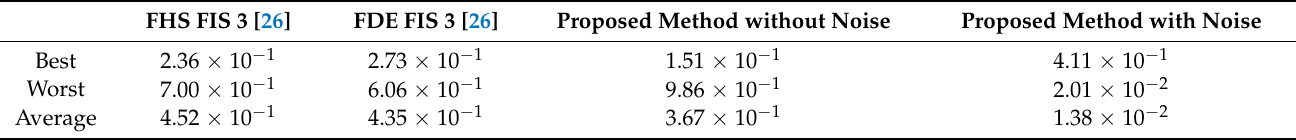
Table 7. Comparison with other existing methods [26].